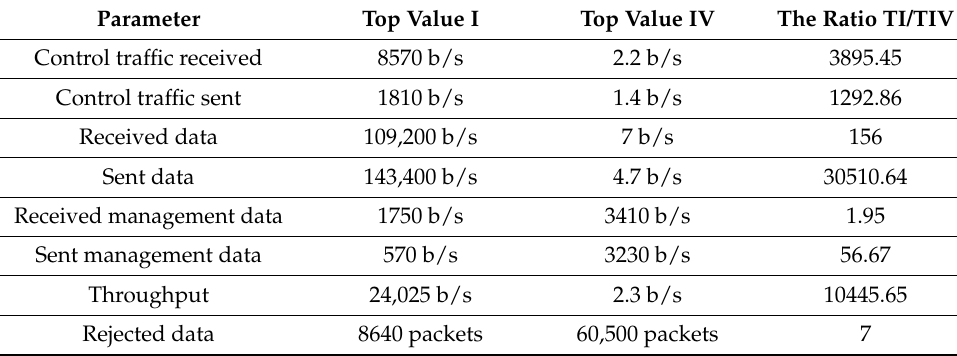
Table 8. The statistics of the network operation in scenarios I and IV.